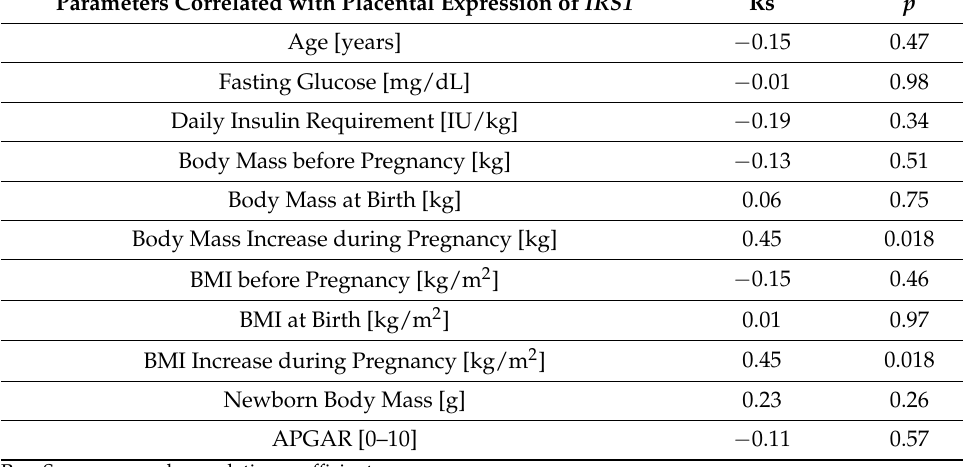
Table 5. Correlations between IRS1 expression in the placenta and clinical parameters in the GDM group ( n =